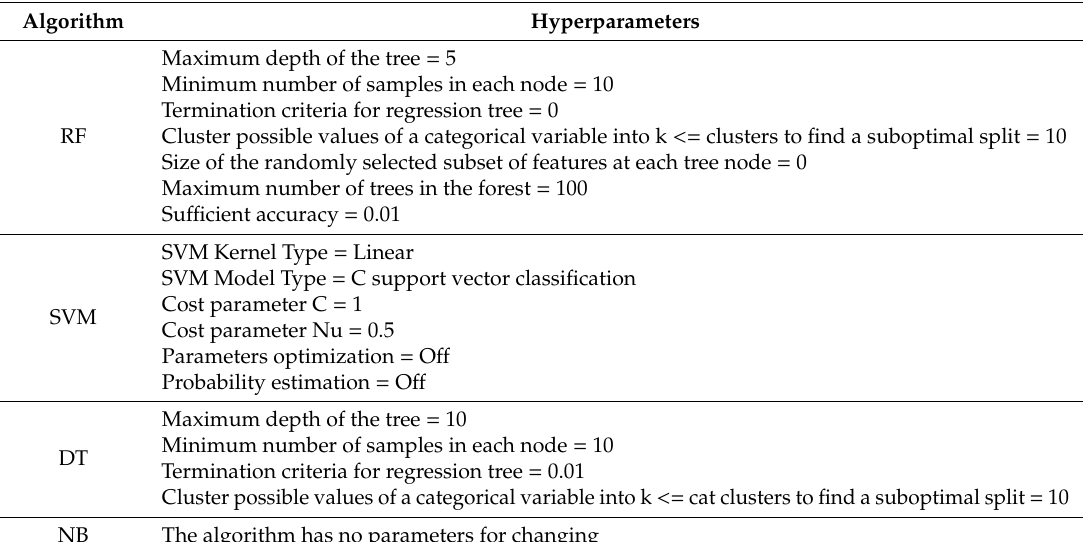
Table 3. ML algorithms adopted to classify forest vegetation in riparian